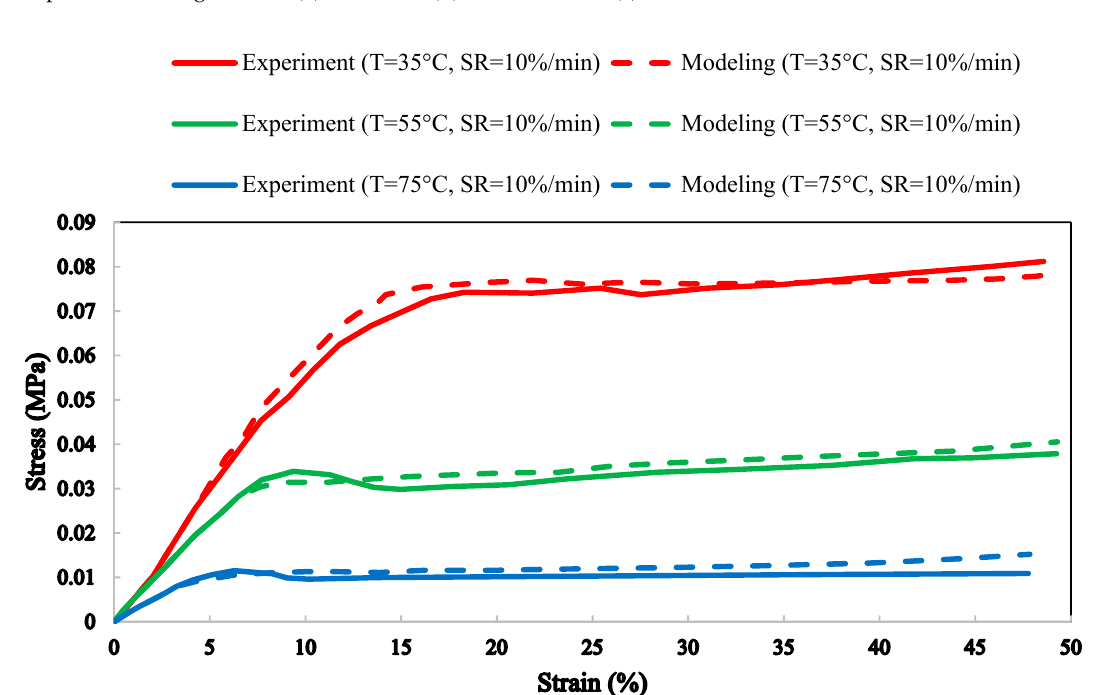
Figure 8. Comparison of numerical and experimental stress-strain curves of PU SMP foams at different temperatures with a strain rate of 10 %/min.